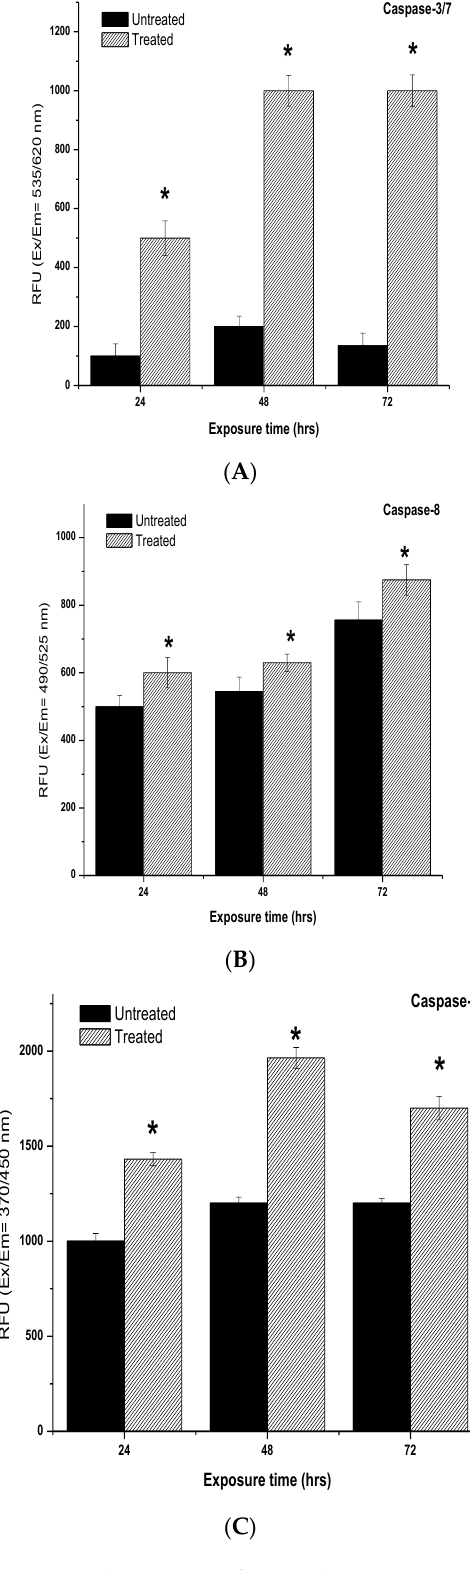
Figure 24. The caspase-3/7, -8 and -9 activities in MCF-7 cells treated for 24, 48 and 72 h. Each data point represents the mean of three independent experiments ± SD. * Significantly different from the control ( p < 0.05). ( A ) 24 h, ( B ) 48 h and ( C ) 72 h of